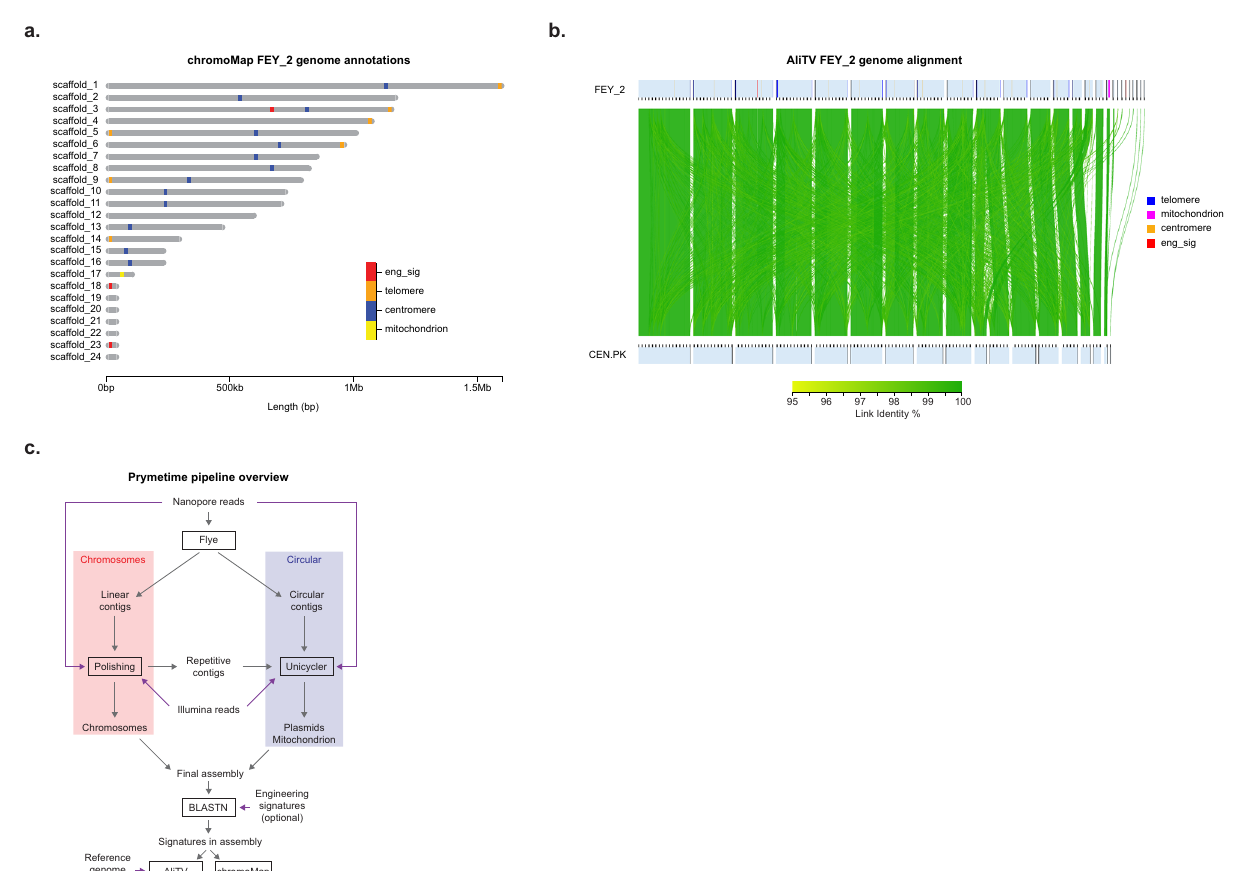
Fig. 5 Visualizing engineering and genome features, and the Prymetime pipeline. a chromoMap interactive visualization displaying engineering signatures and structural elements identi fi ed in the FEY_2 genome assembly. b AliTV interactive visualization of the FEY_2 genome assembly aligned against its parent CEN.PK113-7D genome assembly. Engineering signatures and structural elements are also annotated. c Overview of Prymetime genome assembly